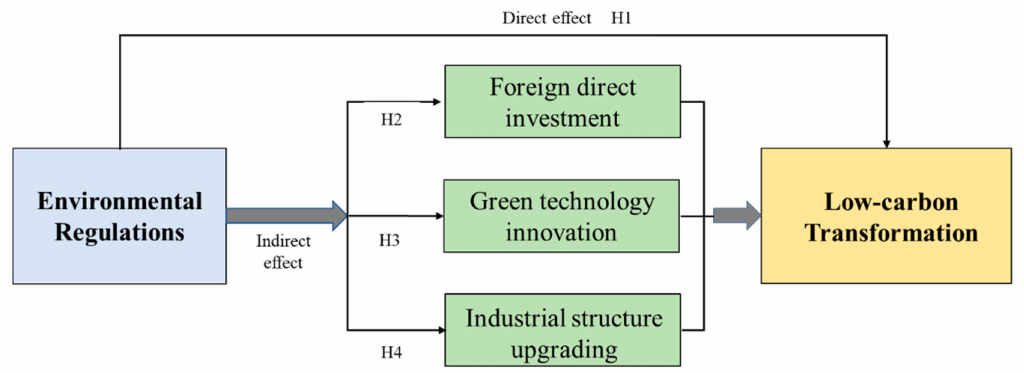
Figure 1. The mechanism of environmental regulations on low-carbon transformation in